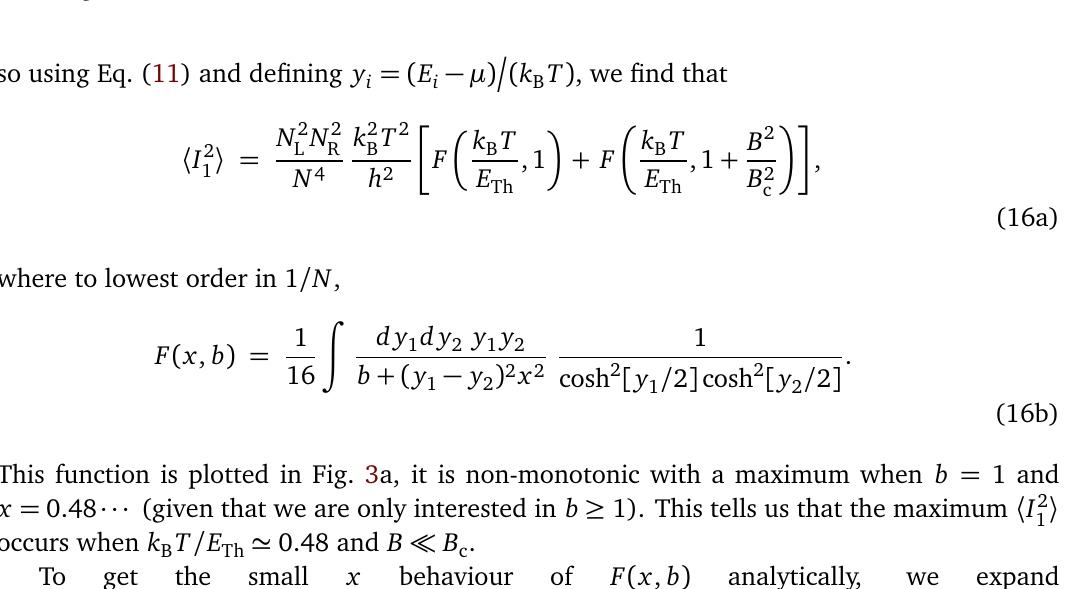
Figure 3: (a) A plot of F ( x , b ) given by the integral in Eq. (16b), for various b (we are only interested in b ≥ 1). The function goes like x 2 for small x (on a scale almost too small to see here), while it goes like 1 / x for large x . (b) A plot of F ( x ,1 )+ F ( x , b ) which appears in 〈 S 2 〉 in Eq. (23) and 〈 ZT 〉 in Eq. (27), with the vertical dash marking the maximum, this maximum is at x (cid:39) 0.48 for b = 1 and b = ∞ , but at slightly larger x for intermediate values of b